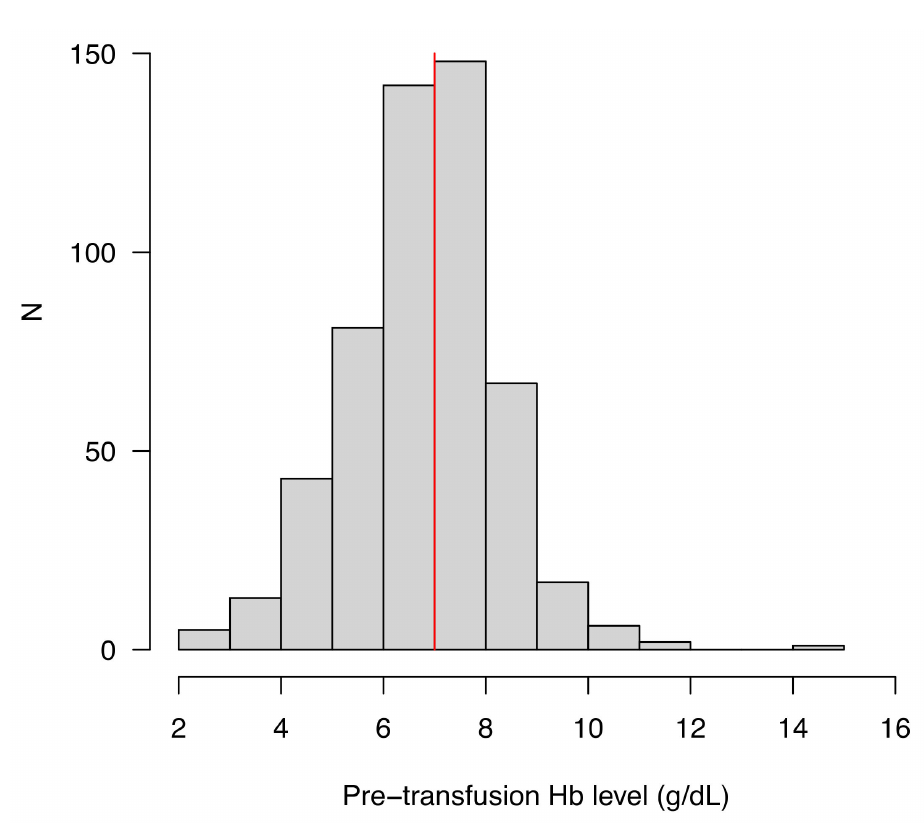
Figure 1. Histogram showing the distribution of the Hb level before transfusion ( N =